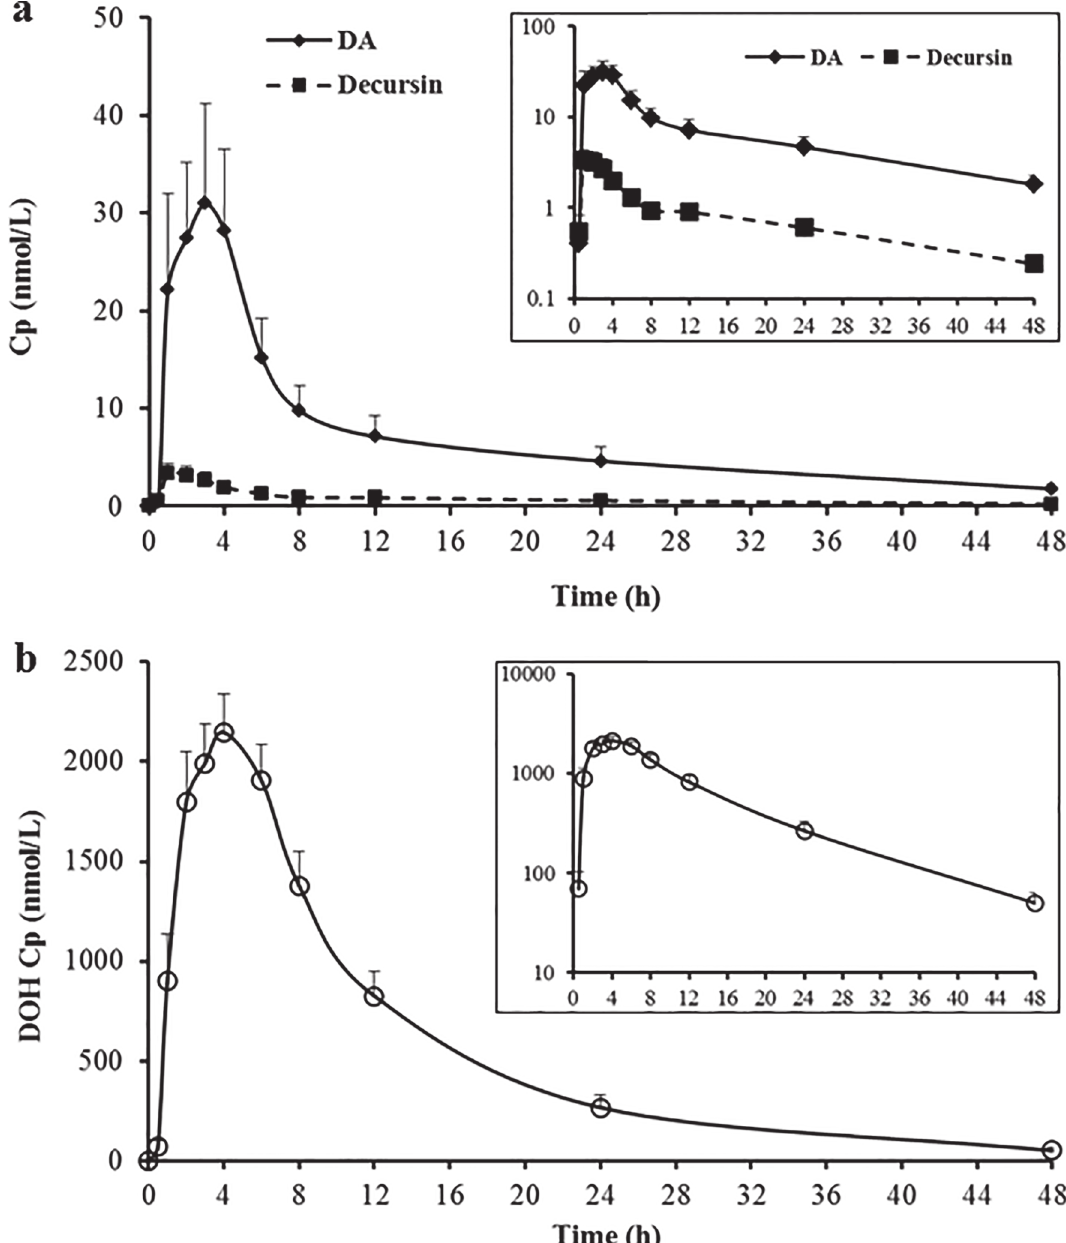
Fig 3. Human plasma concentration (Cp)-time profiles of pyranocoumarins after a single oral dose of Cogni.Q. (a) Parent compounds D and DA. (b) Product DOH. Mean ± SEM of all 20 subjects. Inserts show the semi-log plot of Cp versus time for corresponding analytes. Terminal t 1/2 for D and DA was statistically the same (17.4 and 19.3 hours, respectively) and that for DOH was shorter (7.4